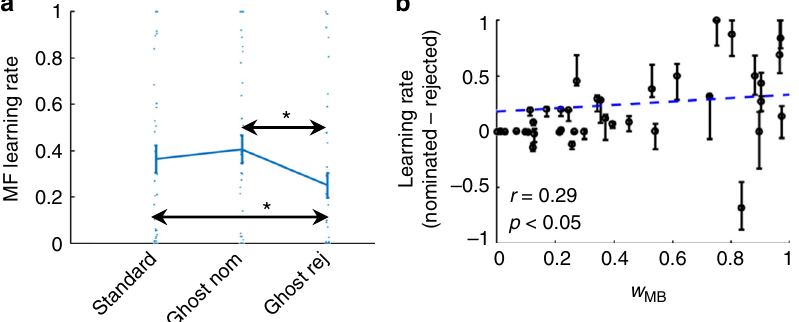
Fig. 6 Analyses based on the ML parameters of the full model. a Group averaged MF learning rates for standard trials, ghost-nominated and the ghost- rejected object. Error bars represent standard errors, n = 40. * denotes p < 0.05 according to a mixed effects linear model. Dots represents individual participants. b The speci fi city of MF learning, i.e. the contrast between learning rates for the ghost-nominated and rejected objects (ordinate), is plotted against the relative MB contribution (abscissa). Each dot corresponds to a single participant. The dashed line is the regression line. Error bars represent the densest interval that contained 50% of the mass of the estimated learning-rate difference distribution obtained by parametrically bootstrapping the data (see methods for details). The p -value was calculated based on a one-sided permutation